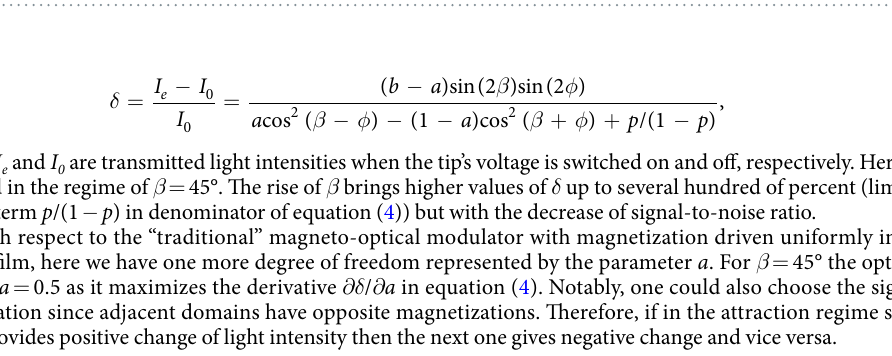
Figure 4. Laser intensity modulation via tip’s voltage for the “small” laser spot. The laser spot diameter is 2 μ m; laser wavelength is 660 nm. Experimental data is shown with spheres; lines are Bézier splines. The in-plane magnetic fields are shown in the plot. Out-of-plane field varies from 0.03 to 0.15